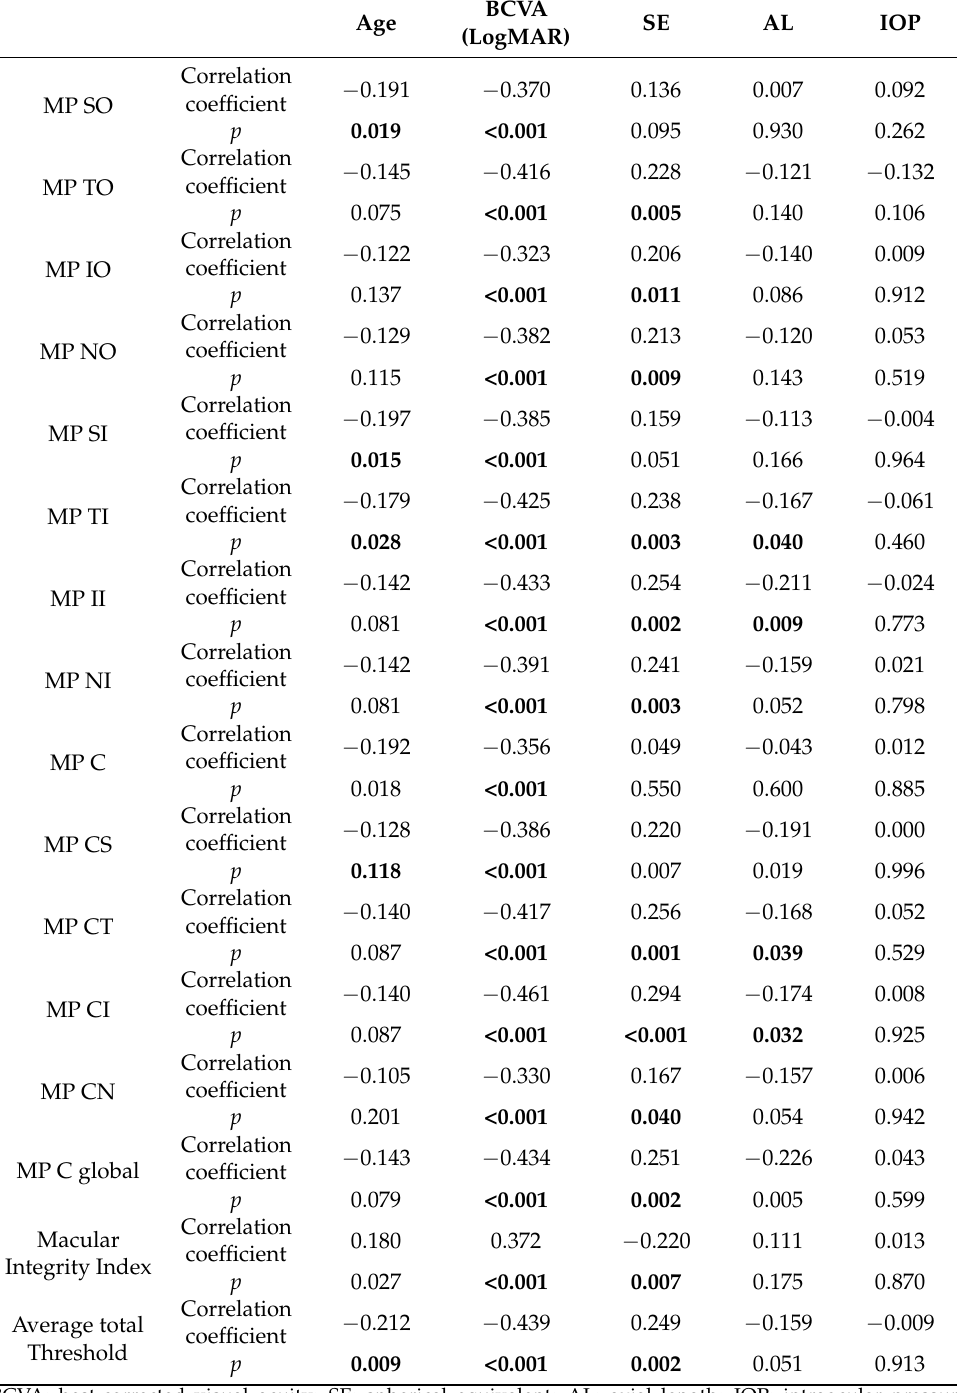
Table 3. Spearman correlations between functional data measured by MAIA and the clinical variables. Significant correlations ( p < 0.05) are highlighted in bold